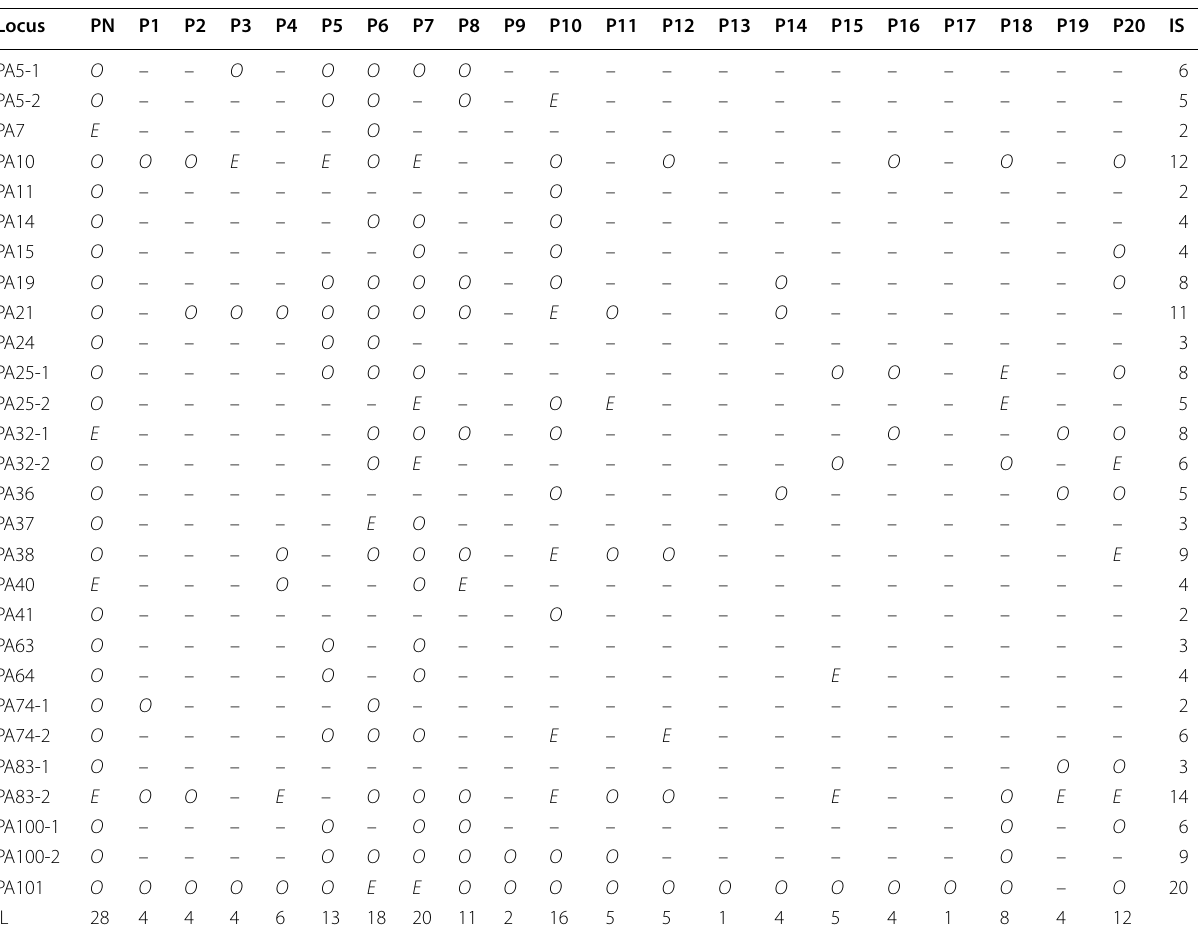
Table 3 The result of the 28 polymorphic microsatellite loci isolated from Phalaenopsis aphrodite subsp. formosana test on 21